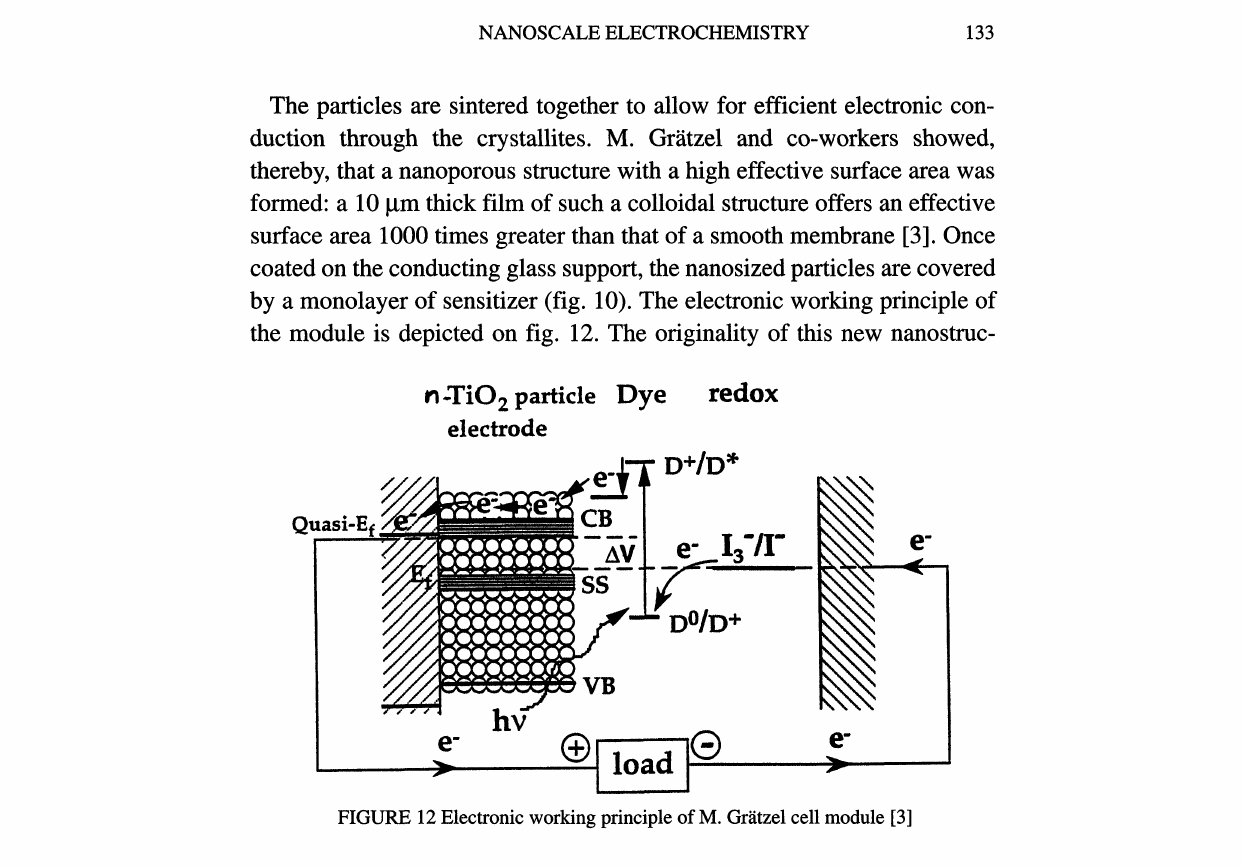
FIGURE 12 Electronic working principle of M. Griitzel cell module